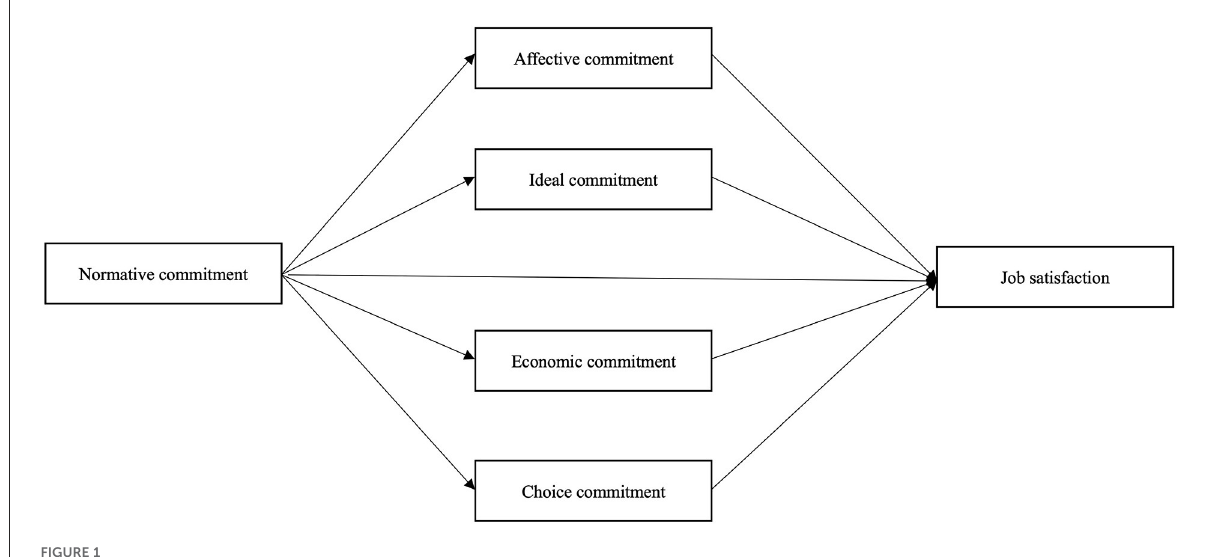
FIGURE1 Hypothesized mediation model of organizational commitment and job satisfaction.